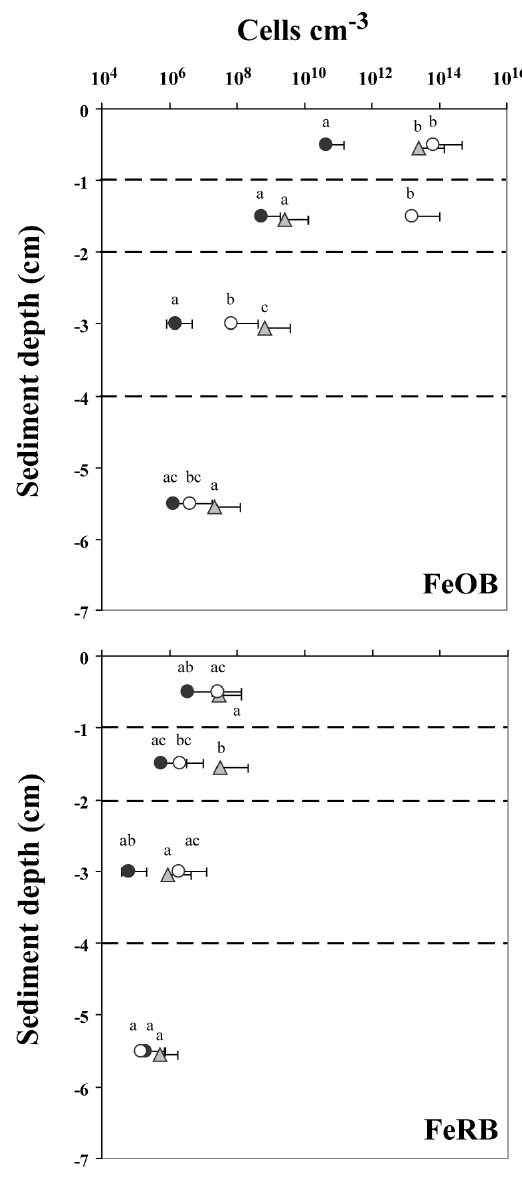
Fig. 6. MPN of Fe-oxidizing bacteria (FeOB) and Fe-reducing bac- teria (FeRB) in the first 7cm of the sediment (0–1, 1–2, 2–4 and 4–7cm layers) at initial conditions (Control: C, – 1 –) and after 16 days in the different treatments (Defaunated: D, – • –; with chi- ronomids: Chir, – ◦ –). Means ± SD ( N = 4). Same letters indicate no significant difference between treatments at each